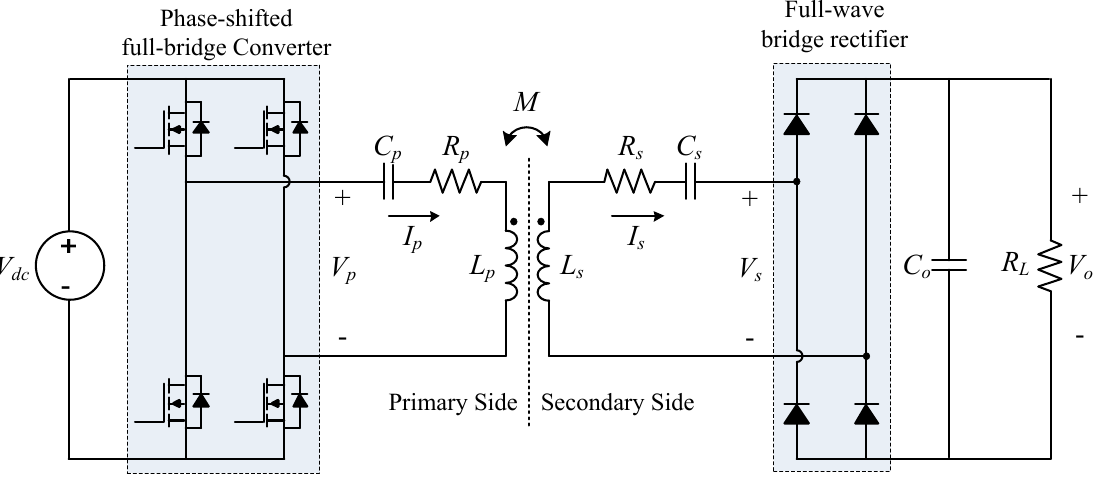
Figure 1. Wireless power transfer (WPT) system based on series-series compensated (SS) topology.